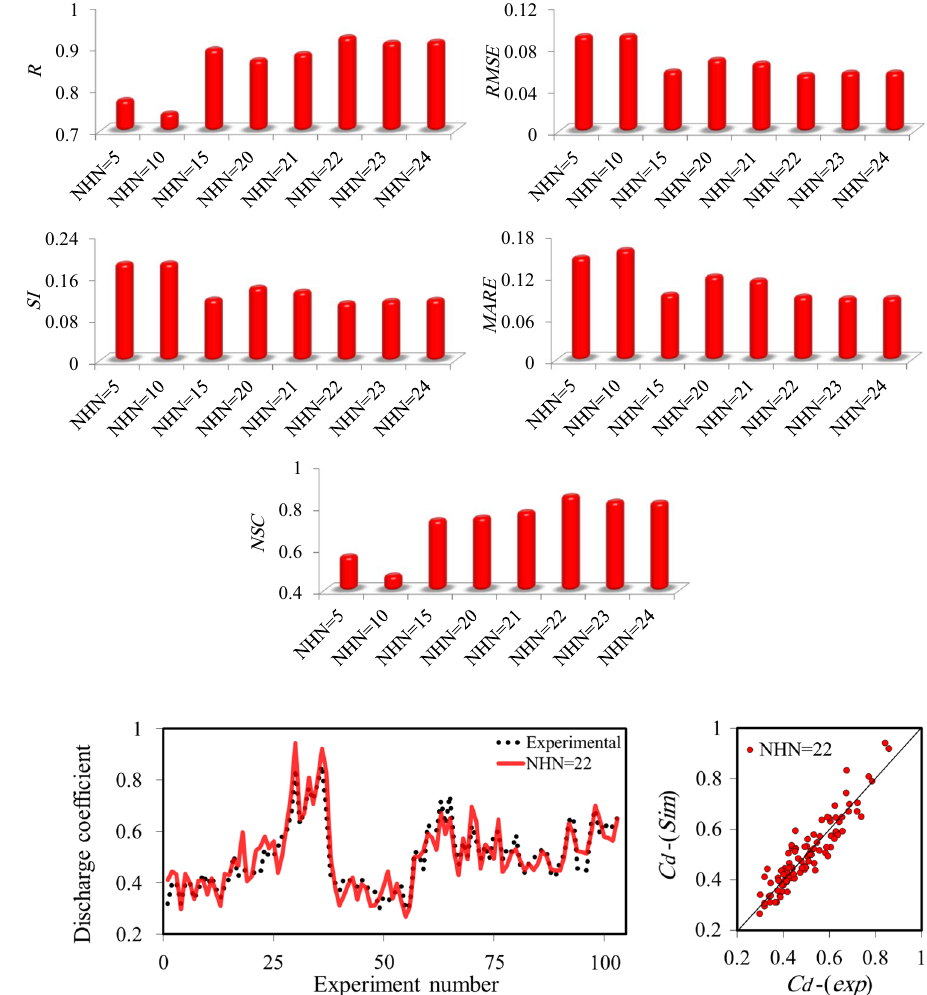
Fig. 4 Values of statistical indices calculated for all hidden layer neurons